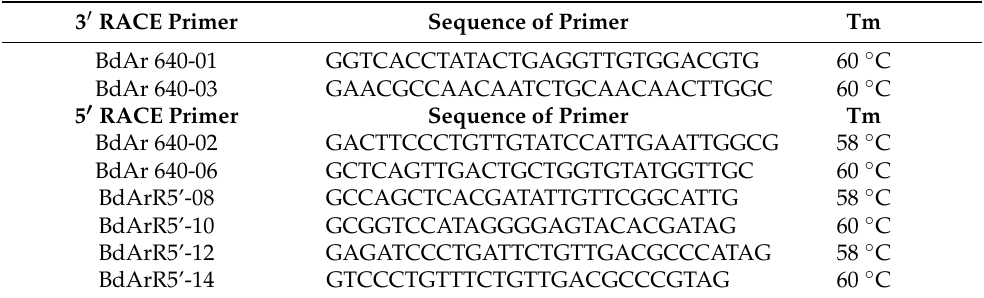
Table 1. Sequences of specific primers used for the rapid amplification of cDNA ends